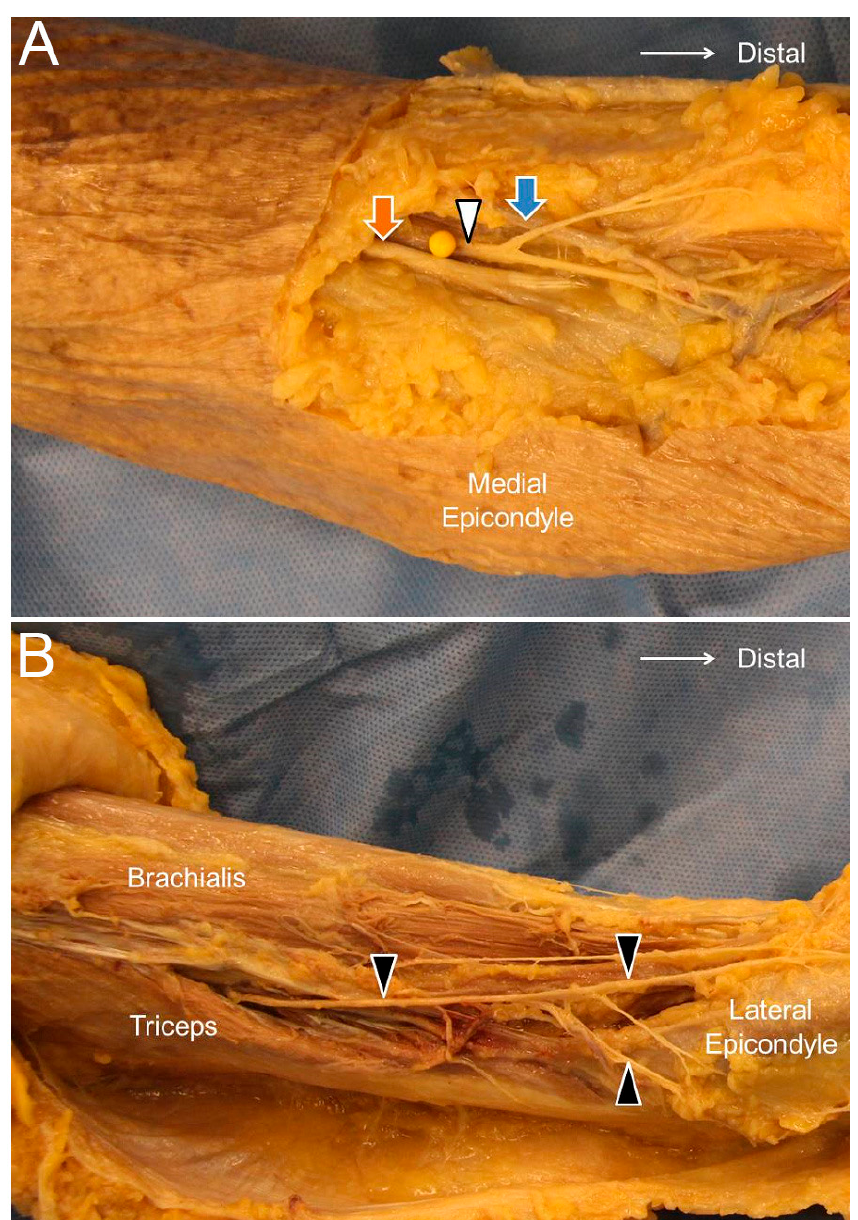
Figure 4. The lateral antebrachial cutaneous nerve (white arrowhead) at the elbow level (A) and the posterior antebrachial cutaneous nerve (black arrowhead) at the distal forearm level (B) . Orange arrow, distal biceps tendon; blue arrow, cephalic vein.